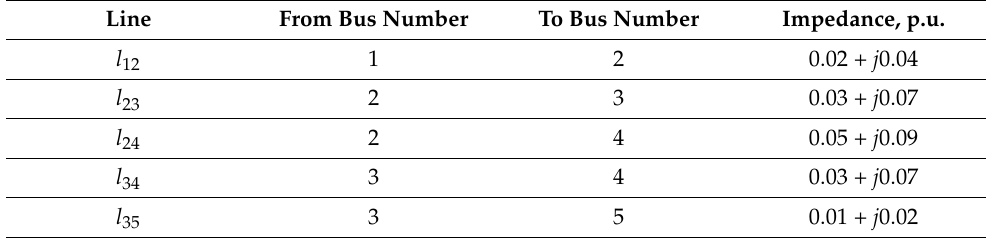
Table 3. Voltage stability system indices for the radial five-bus network with G 2 and l 24 out of oper- ation when all loads increase.